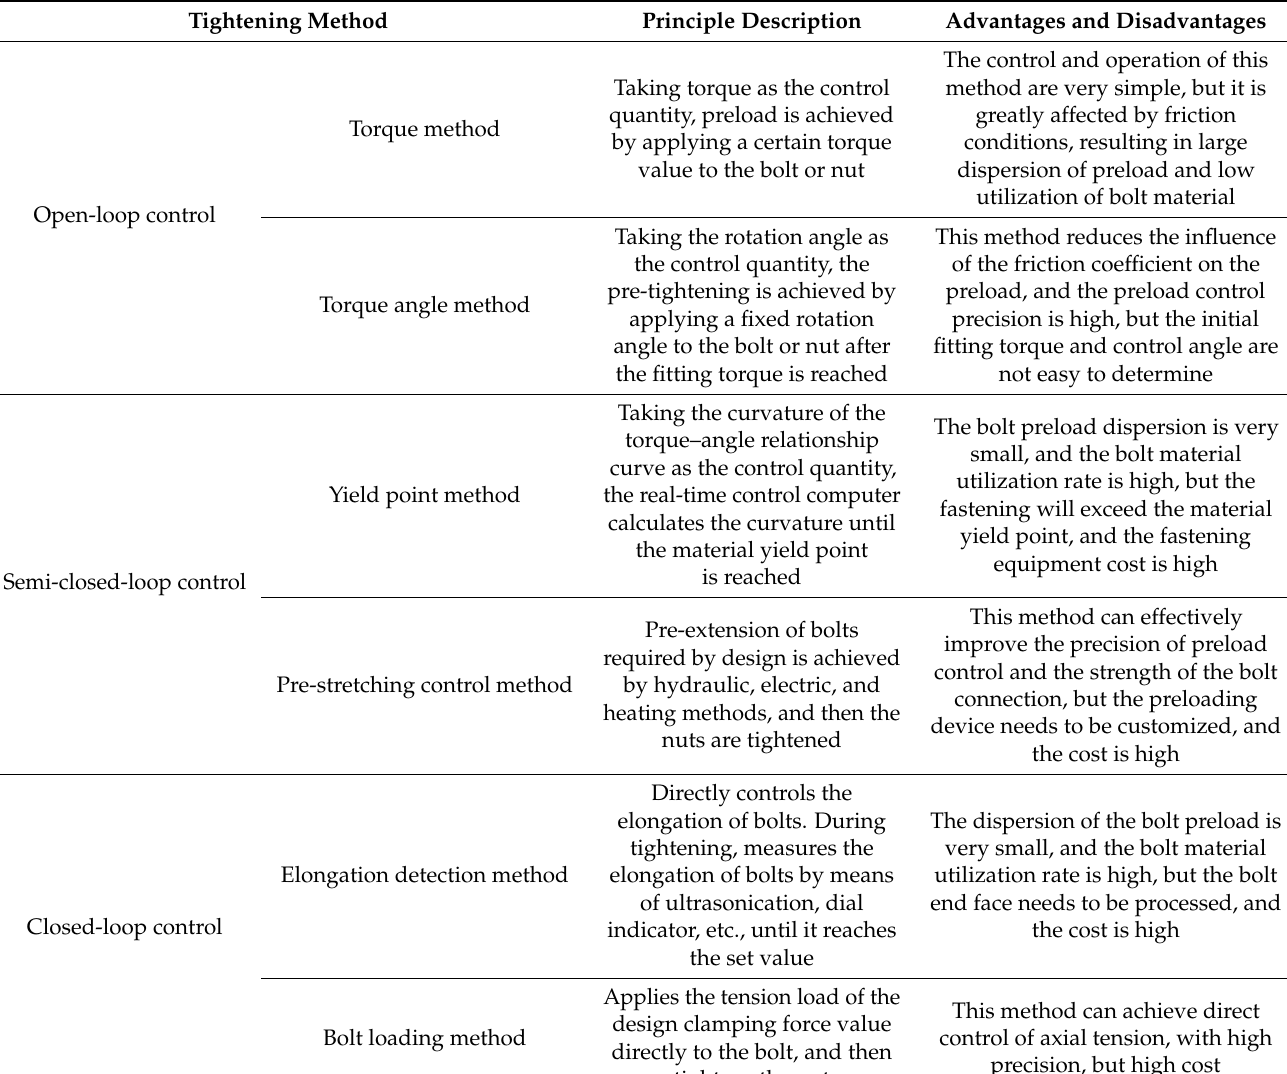
Table 1. Summary of bolt tightening